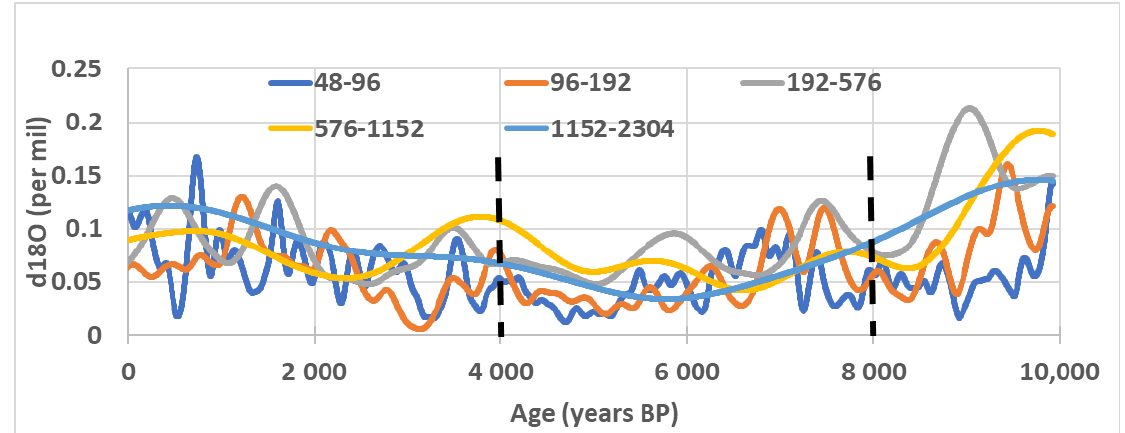
图 5 Figure 5. Amplitude of the speleothem (entity 142) decomposed in subharmonic modes. The limits of the regions in which the components are averaged are